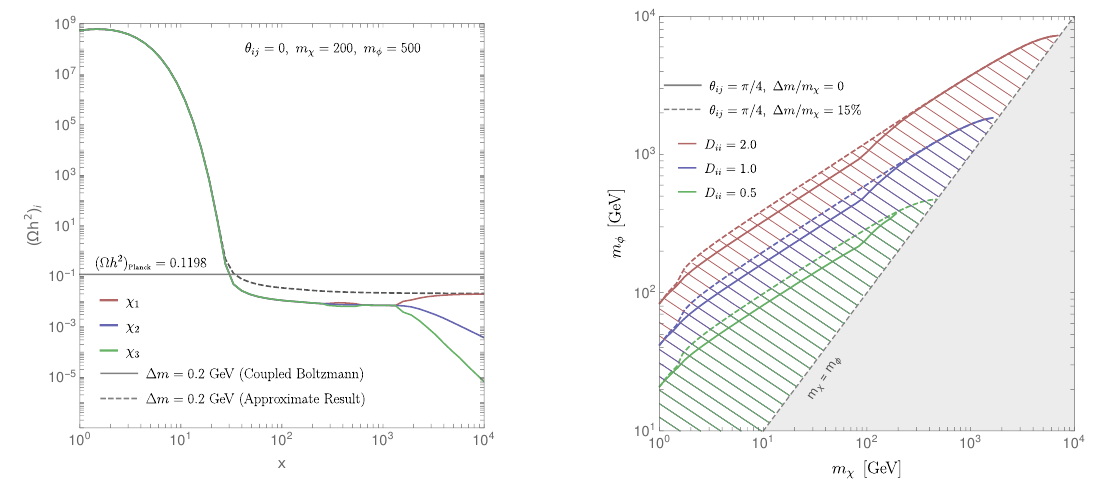
) as freeze out occurs (left), and the (cid:31) =T